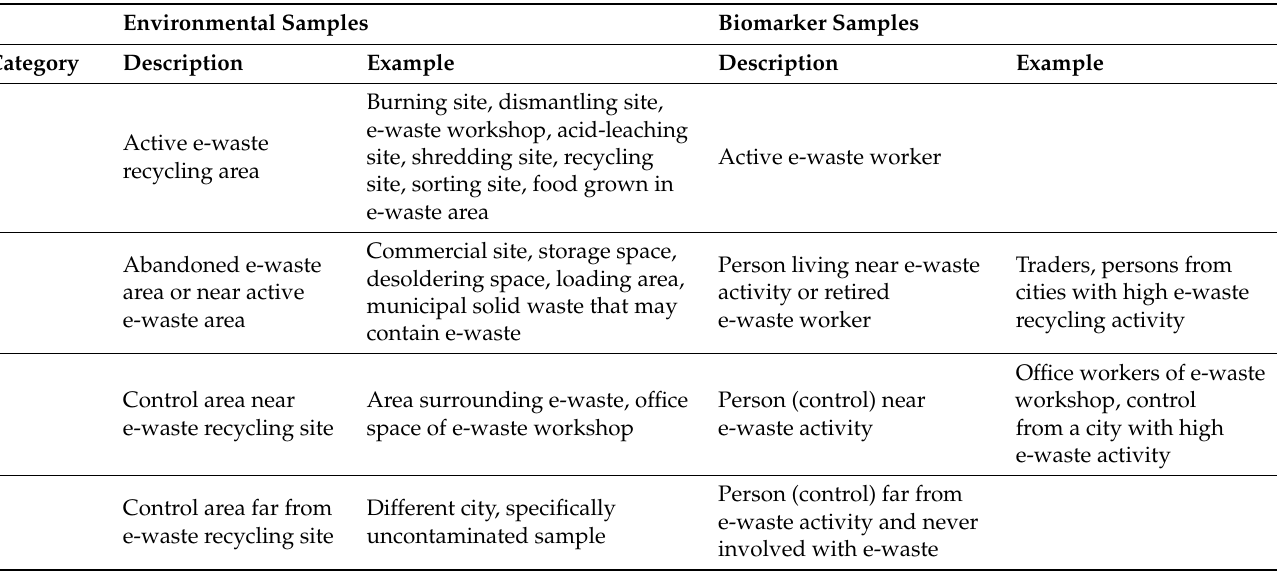
Table 1. Mercury Exposure Group Categories.